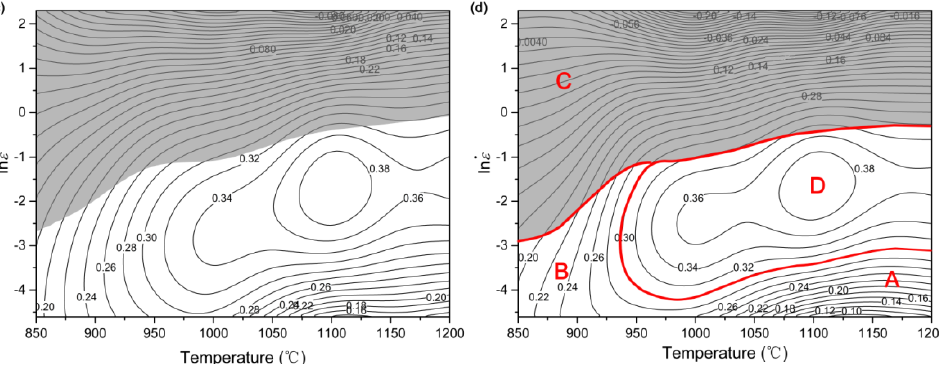
Figure 5. Processing maps of 30Cr2Ni4MoV steel at strains of ( a ) 0.2; ( b ) 0.4; ( c ) 0.6; and ( d ) 0.7.